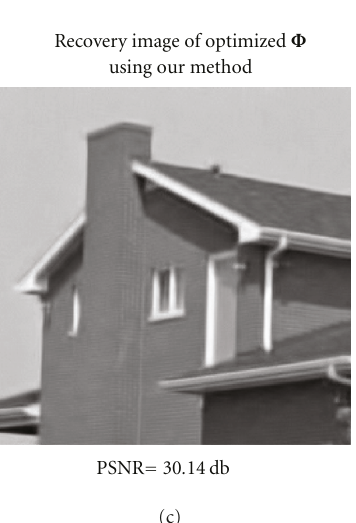
Figure 8: Recovered image before and after optimization. (a) Recovered using random Φ , (b) recovered using optimized Φ by Elad’s method, and (c) recovered using optimized Φ by our proposed